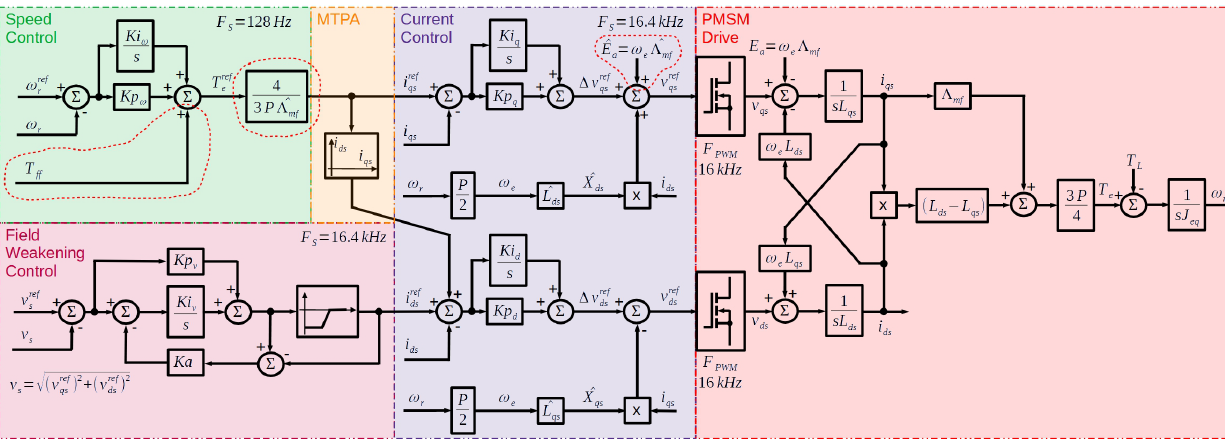
Figure 31. PMSM Drive Control with proposed